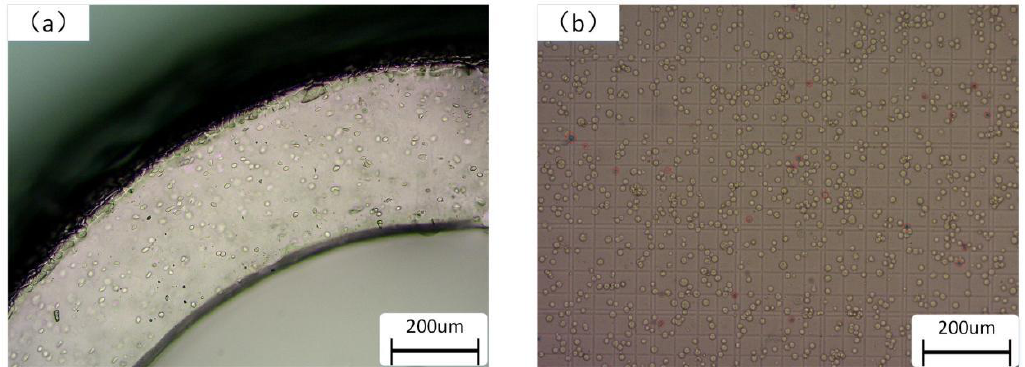
Figure 11. Cell survival of cell-laden vessel-like structure. ( a ) The printed cells distributed in the vascular structure and ( b ) cell survival rate statistics.